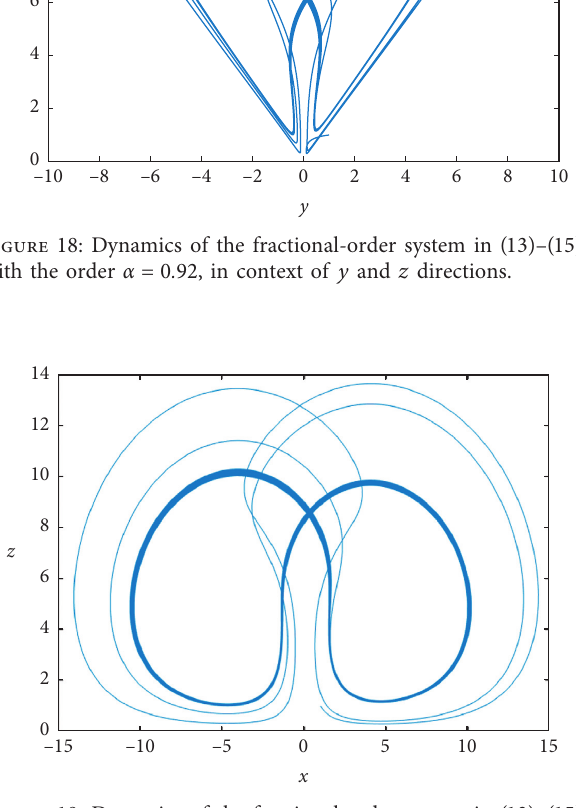
Figure 19: Dynamics of the fractional-order system in (13)–(15) with the order α � 0 . 92, in context of x and z directions.